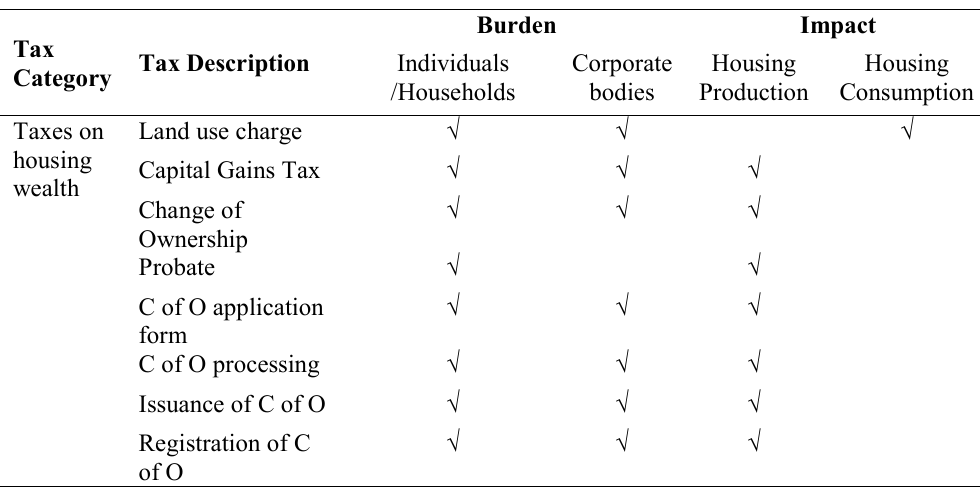
Table 3. Property Tax Burden and Impact on Housing Production